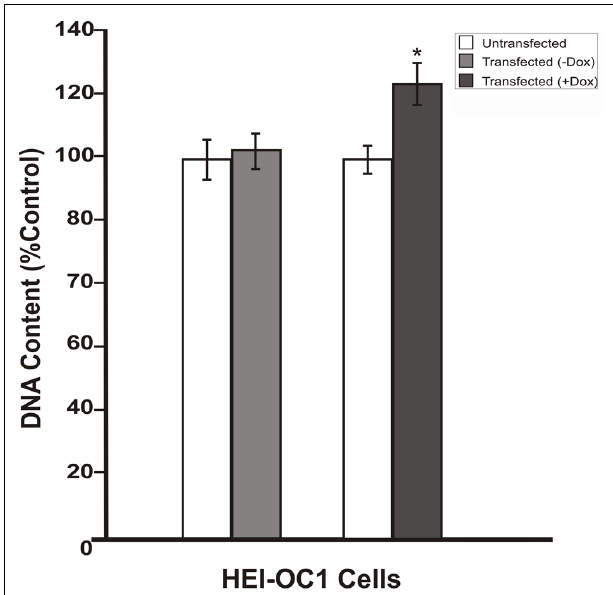
FIGURE 4 | Dox-mediated DN-CBRb transgene activation increases cell proliferation. HEI-OC1 cells co-transfected with purified pTet-Splice-DN-CBRB and the pCMV-Tet3G vectors were cultured in the absence ( − ) or presence ( + ) of Dox. Cell proliferation was determined 48 h after transfection using CYQUANT NF Proliferation Assay. Percentage change in proliferation was calculated using change in fluorescence values with untransfected cells as control. A modest, but significant increase in cell number was observed on transfected cells following Dox treatment. In contrast, no significant changes were observed between transfected HEI-OC1 cells not treated with ( − Dox) and the untransfected control. * P <